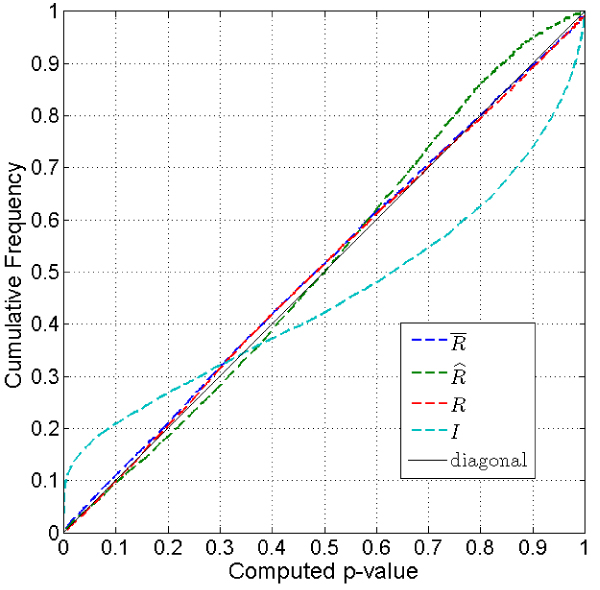
Cumulative distribution of p-values for two-sided test case with sample size n = 15. A better correction is also seen with larger sample sizes in two-sided case. In this case we have more accurate estimate of the true correlation R.